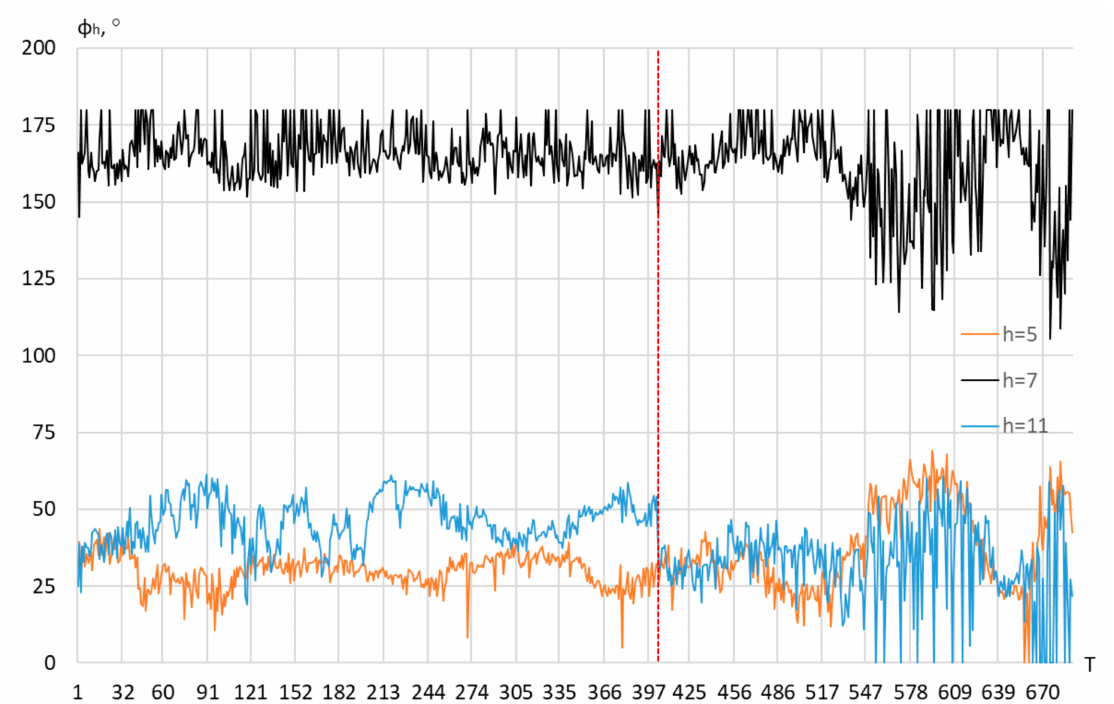
Figure 6. The diagram of the phase shift angle at the 5th, 7th, and 11th harmonic (before red line—capacitor banks are connected; after red line—capacitor banks are